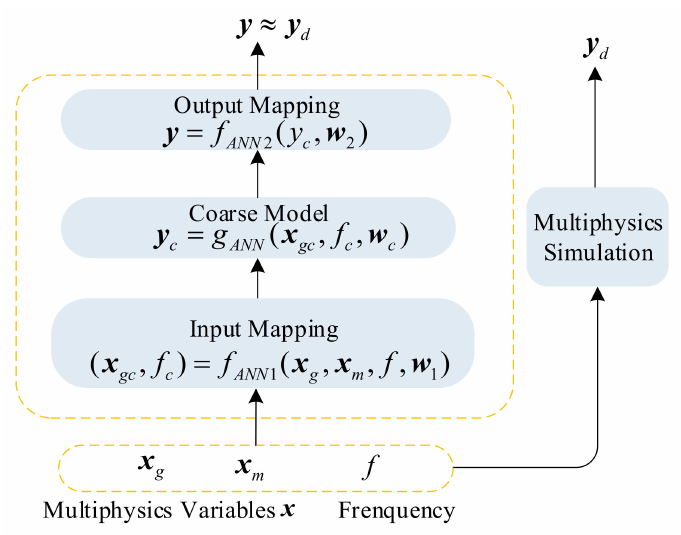
Figure 1. Structure of the proposed Neuro-SM multiphysics parametric